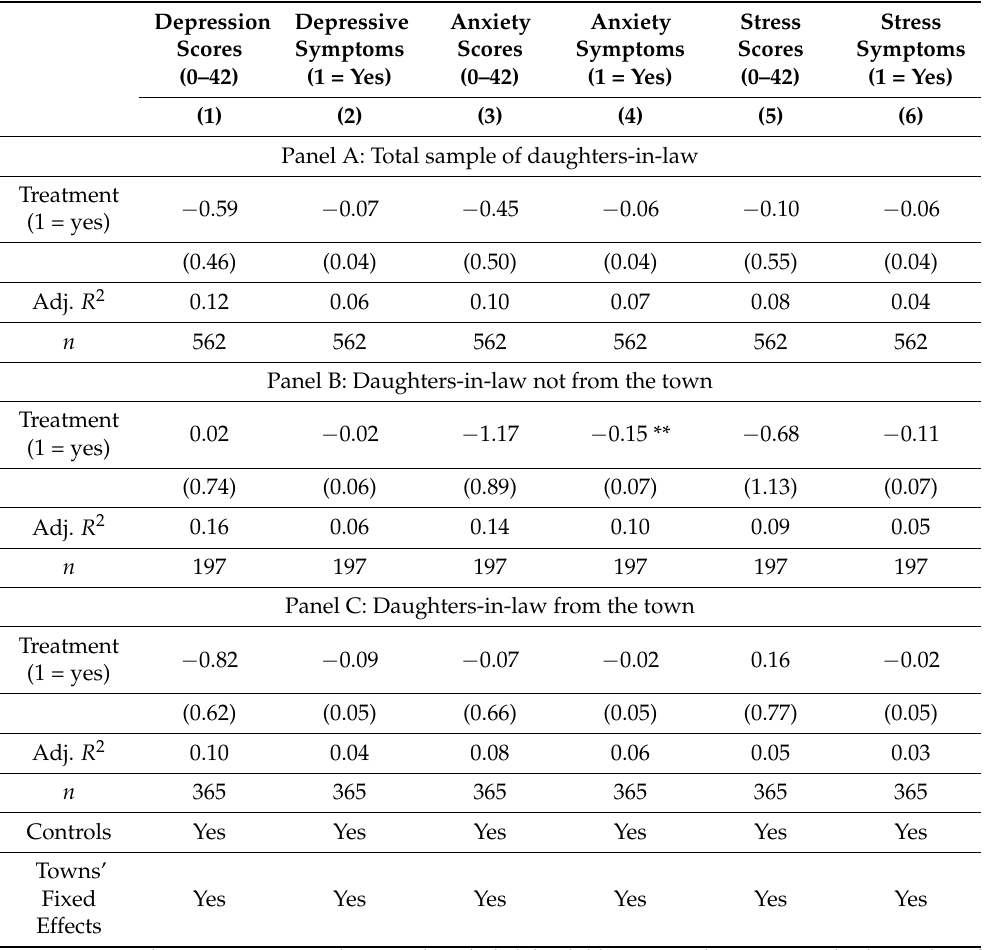
Table 7. Program’s effect on the mental health of the daughters-in-law.